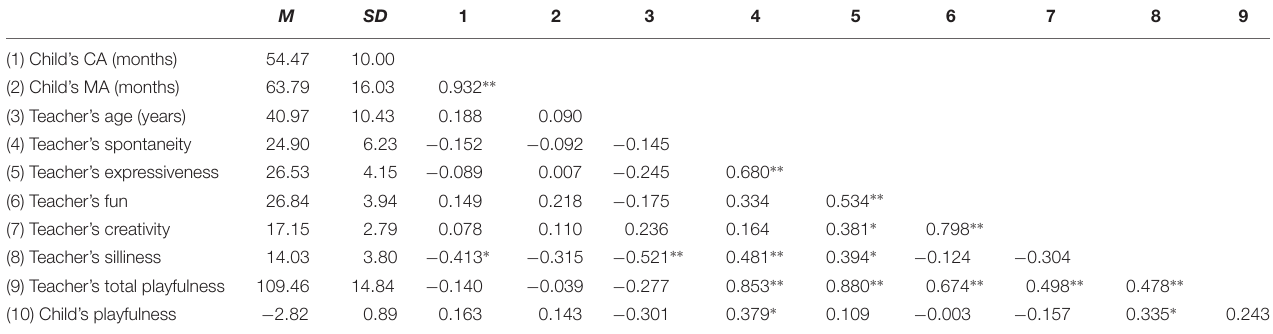
TABLE 1 | Descriptive statistics and inter-correlations ( N = 32). M SD